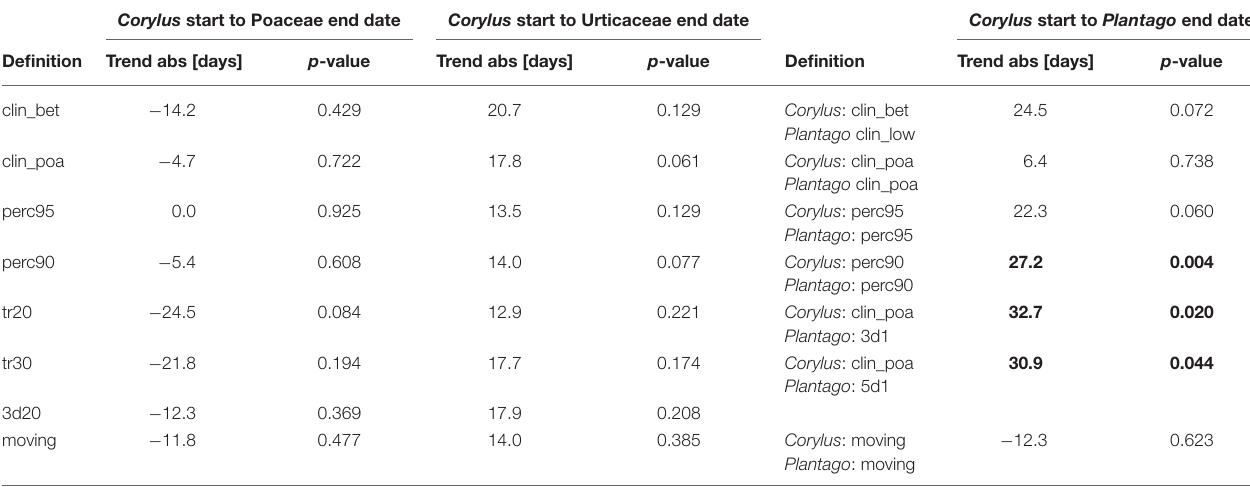
TABLE 3 | Absolute linear trends of the duration of the whole pollen season 1969–2018 from the Corylus flowering until the end of flowering of herbaceous taxa with different pollen season definitions.